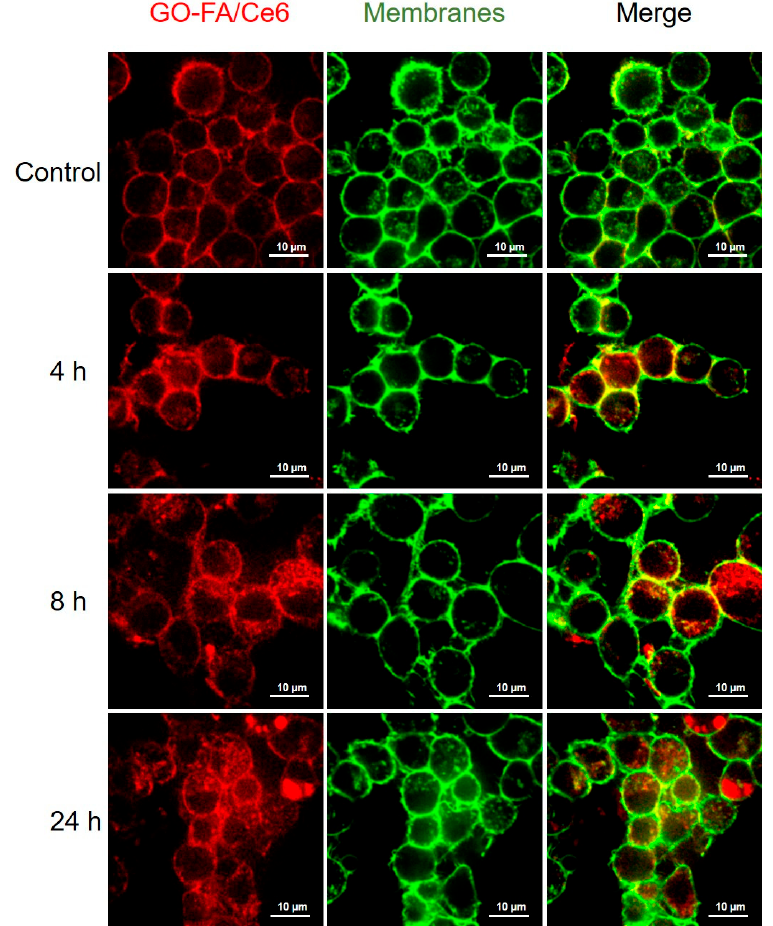
Figure 9. Confocal microscopy images of RAW 264.7 macrophages incubated with 25 μ g ∙ mL − 1 of GO–FA/Ce6 at different time points. The untreated RAW 264.7 macrophages were used as control. In green, membranes stained with CellMask (excitation channel: 488 nm, emission: 500–550 nm); in red, GO–FA/Ce6.